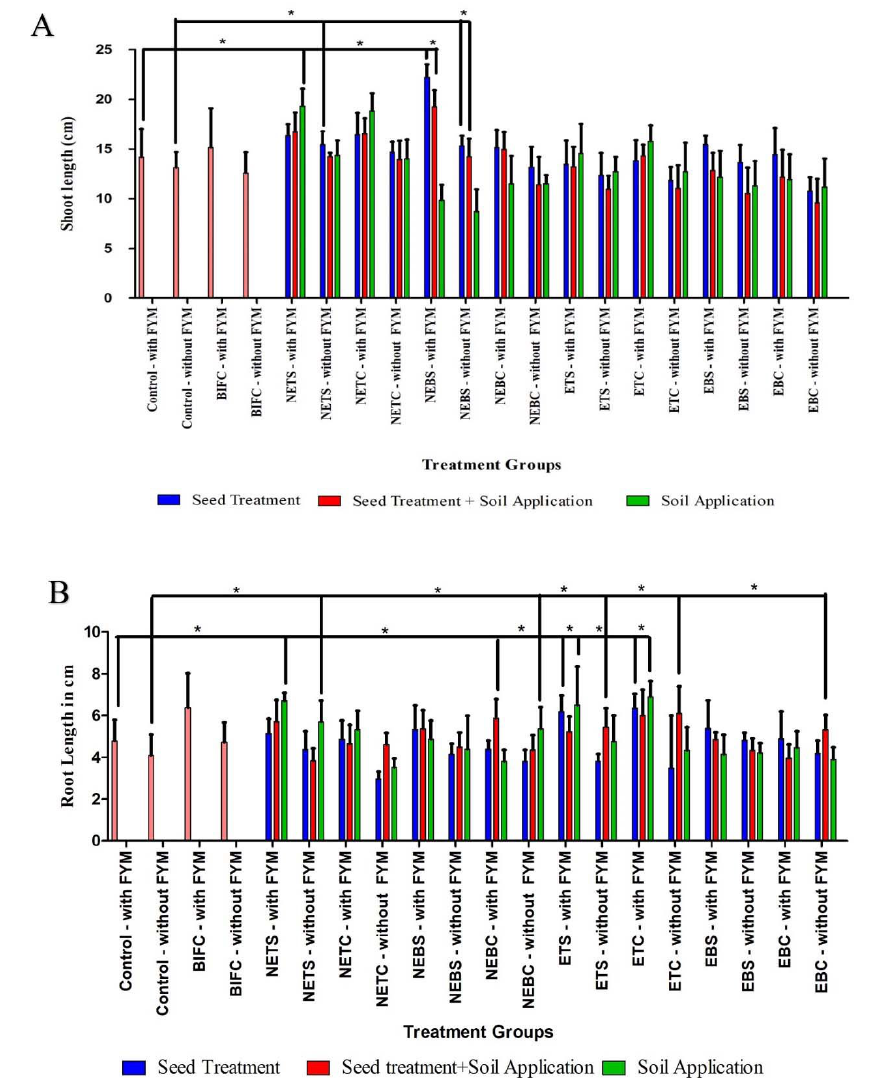
Graph 2. Effect of Bio formulation on growth of rice plant on 21 st day of seed sowing in shoot length (A); and 30 th day of seed sowing in root length (B) for the Soil with and without FYM